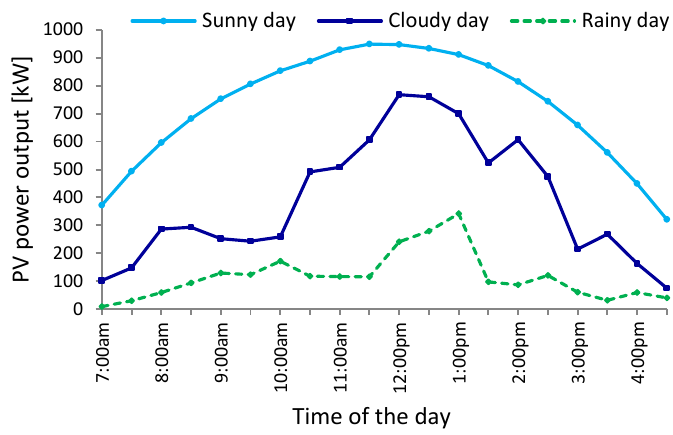
Figure 1. Typical patterns of solar power output under different weather conditions: for a sunny day